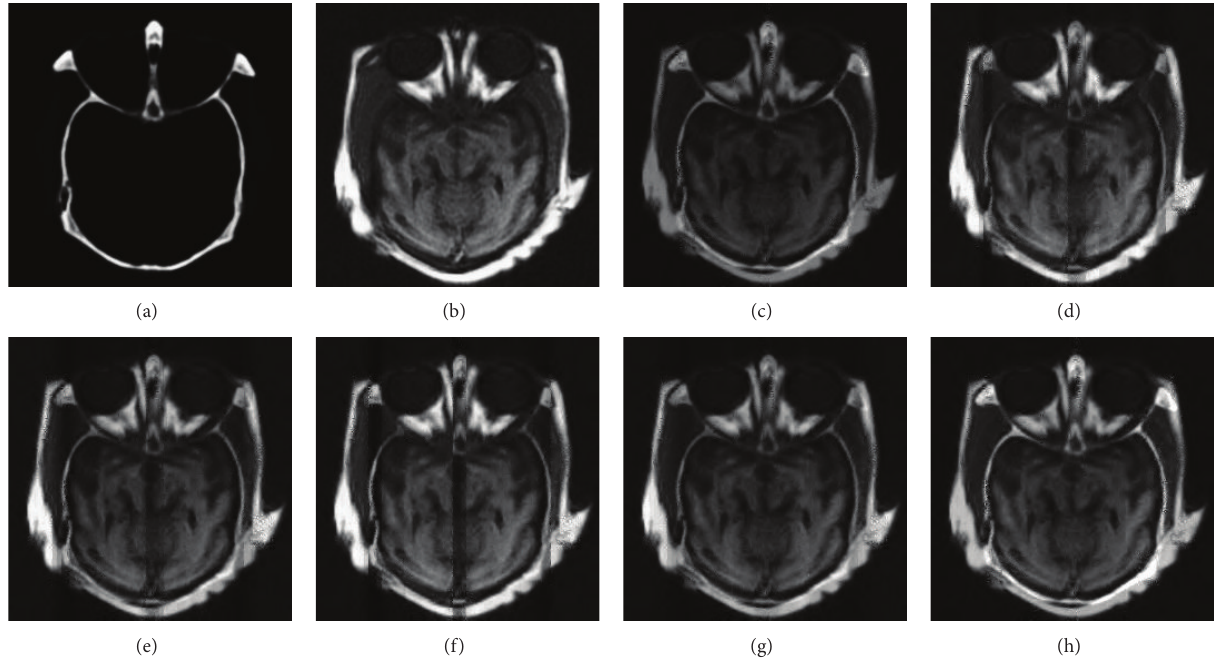
Figure 3: (a) CT image, (b) MRI image, (c) fusion result of average scheme, (d) fusion result of mean scheme, (e) fusion result of variance scheme, (f) fusion result of PCA scheme, (g) fusion result of MI scheme, and (h) fusion result of the proposed method.